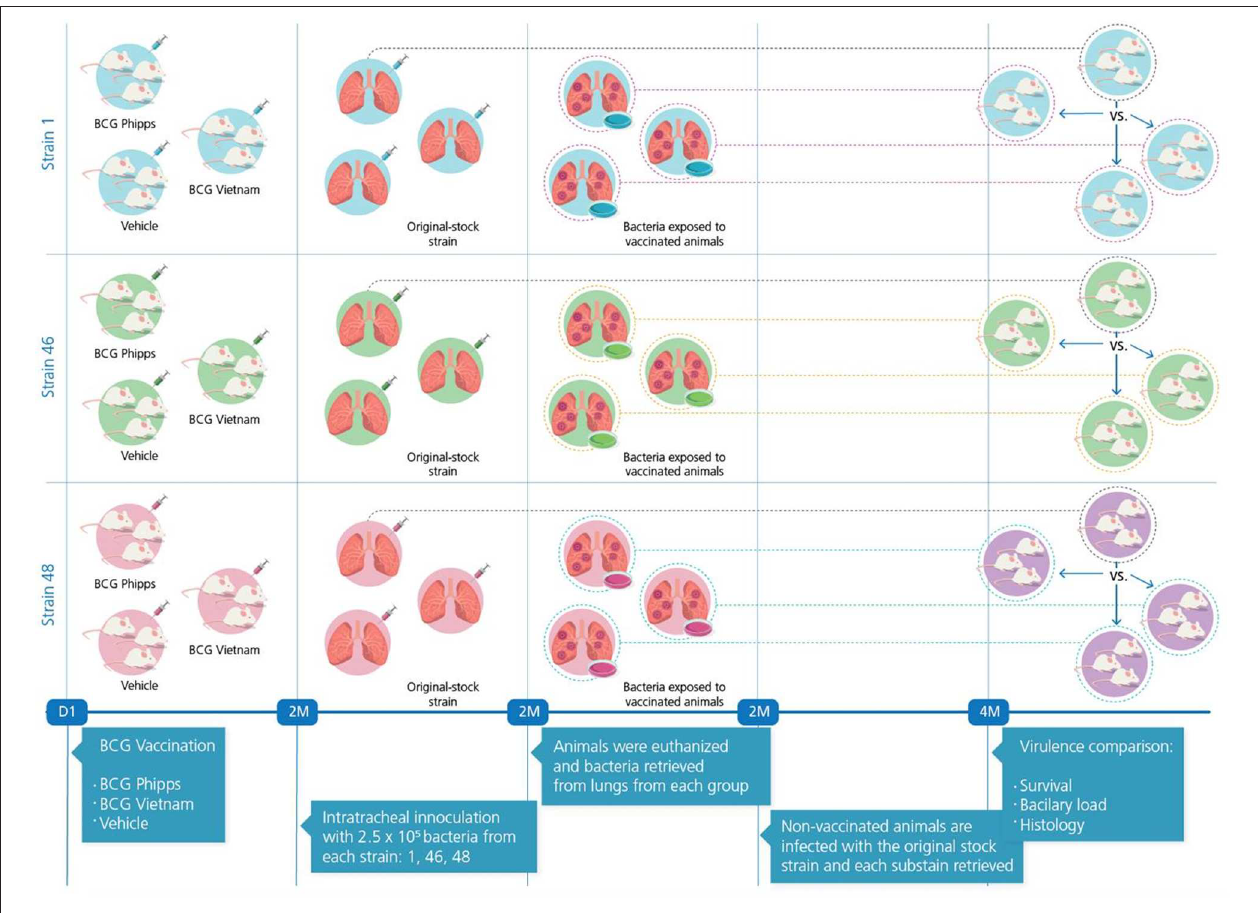
FIGURE 1 | Experimental strategy.